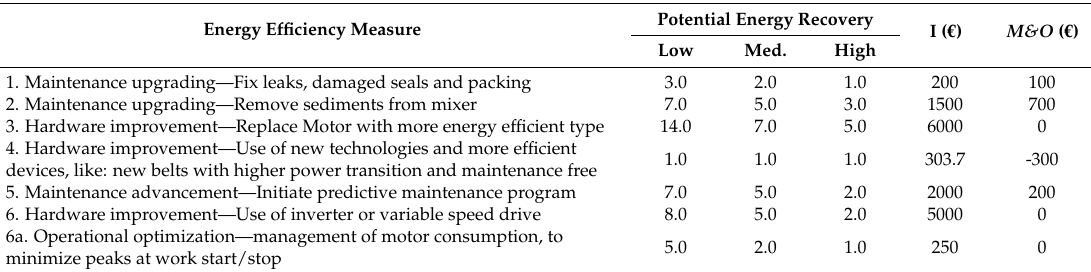
Table 5. Efficiency improvement % over each base case scenario for the electric motor system (case